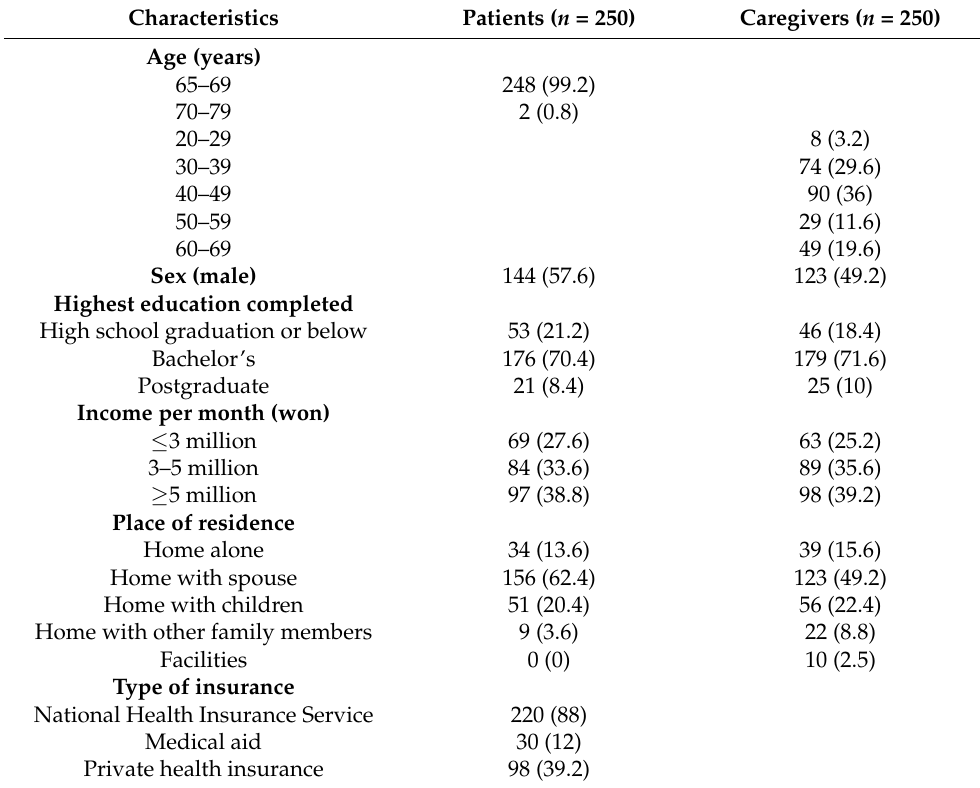
Table 1. Participant